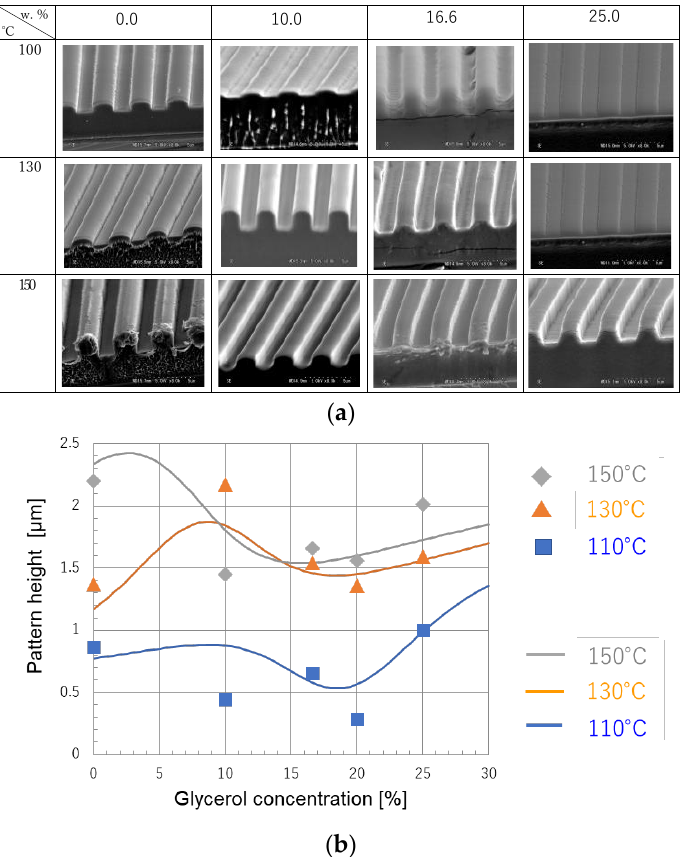
Figure 4. Experimental learning data and learning results. ( a ) The scanning electron microscope (SEM) images of experimental results for PVA with glycerol (pressure: 10 MPa, 2.0 µ m line and space). ( b ) Experimental results for learning data at various glycerol concentrations under limited process conditions. Diamonds, triangles, and squares are averages of the experimental results. Solid lines are the predicted results by learning for various glycerol